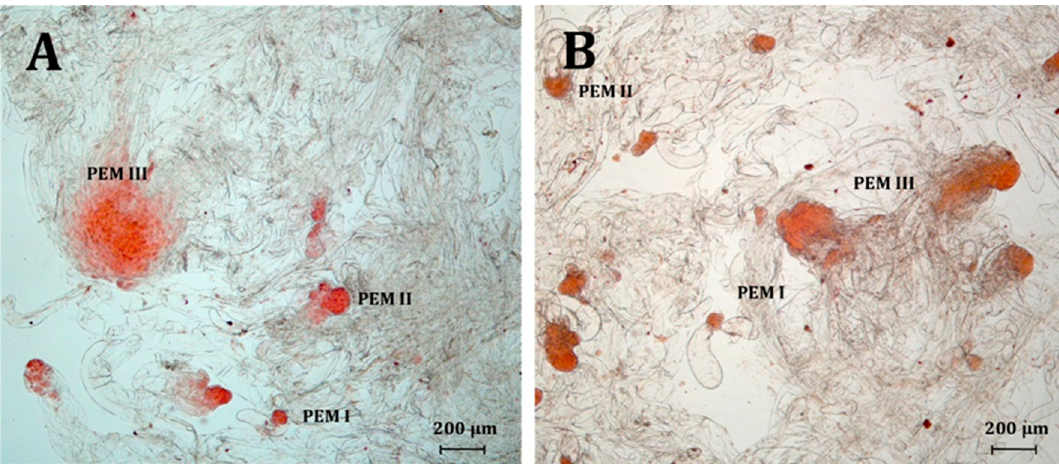
Figure3. Morphology of variousembryogenic structures in: ( A ) P. abies and ( B ) P. omorika . proembryonic Figure 3. Morphology of various embryogenic structures in: ( A ) P. abies and ( B ) P. omorika . structures (PEM) I–III – embryogenic structures type proembryonic structures (PEM) I–III – embryogenic structures type I–III. Table 4. The number (ratio) of proembryogenic structures and the mean size of the embryogenic region (µm, mean ± standard error). Different letters within columns indicate statistically significant differences between means for PGRs type within species ( p < 0.05).